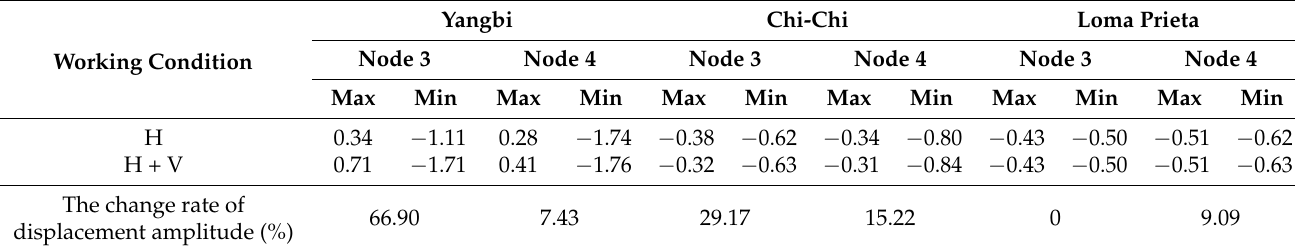
Table 7. Peak displacement of the top layer in the UD direction/mm.